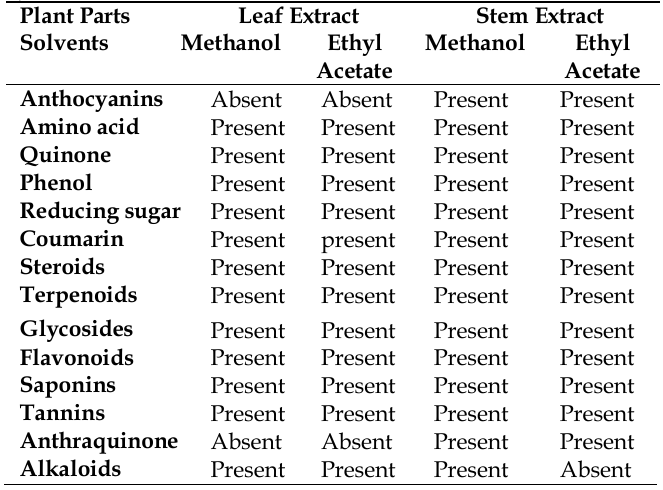
Table 1 : Qualitative Analysis of Different Parts of